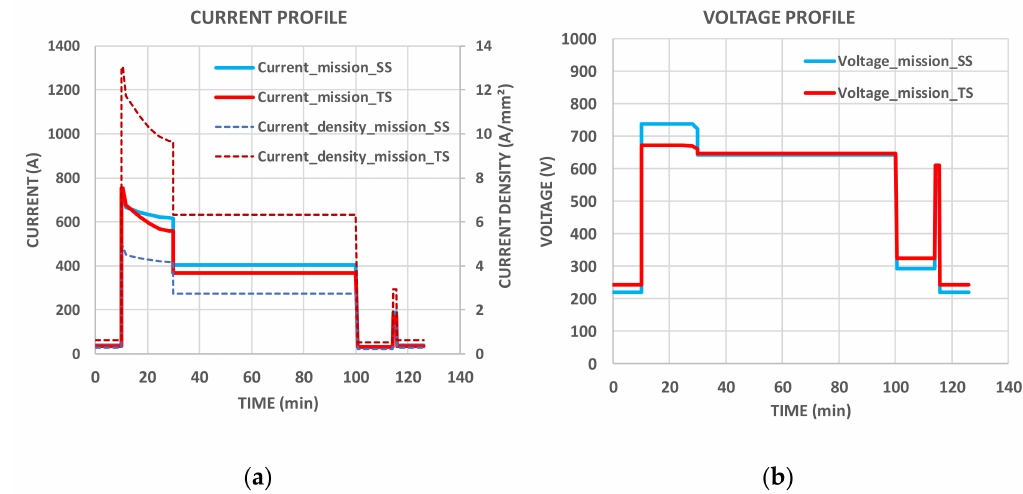
Figure 17. Electrical variables in the two electric motors (blue: the steady-state thermal model optimization, red: the transient state one). ( a ) Current and current density, and ( b )